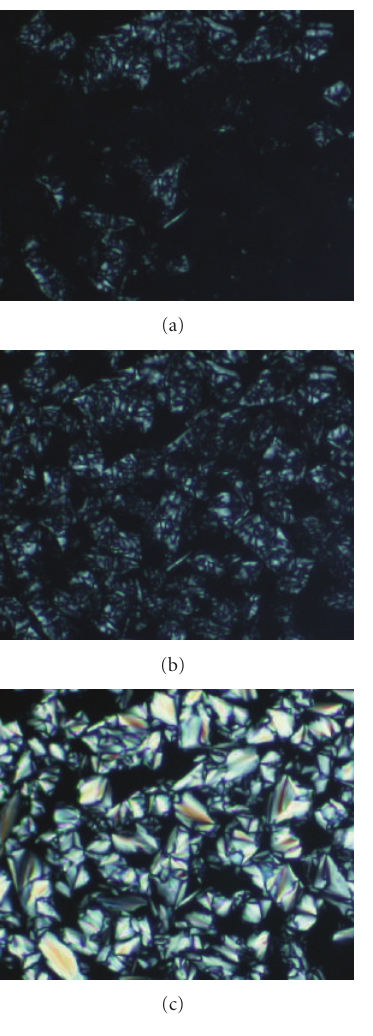
Figure 16: Polarized optical micrographs of cholesteryl nonanoate dispersed in UV15 taken during cooling from the isotropic phase at (a) 90.4 ◦ C, (b) 71.6 ◦ C, and (c) 25 ◦ C.